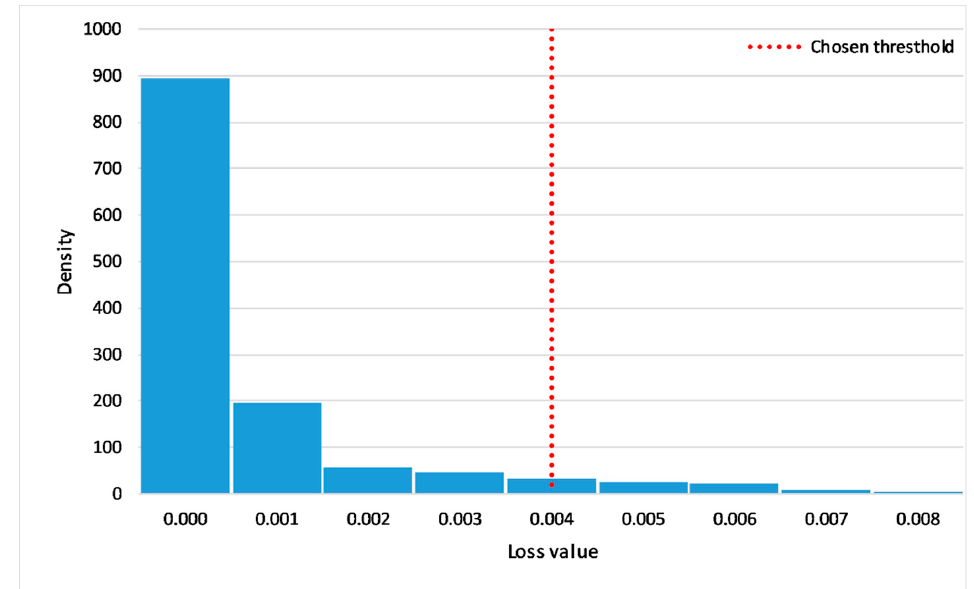
Figure 6. Distribution of the prediction error.